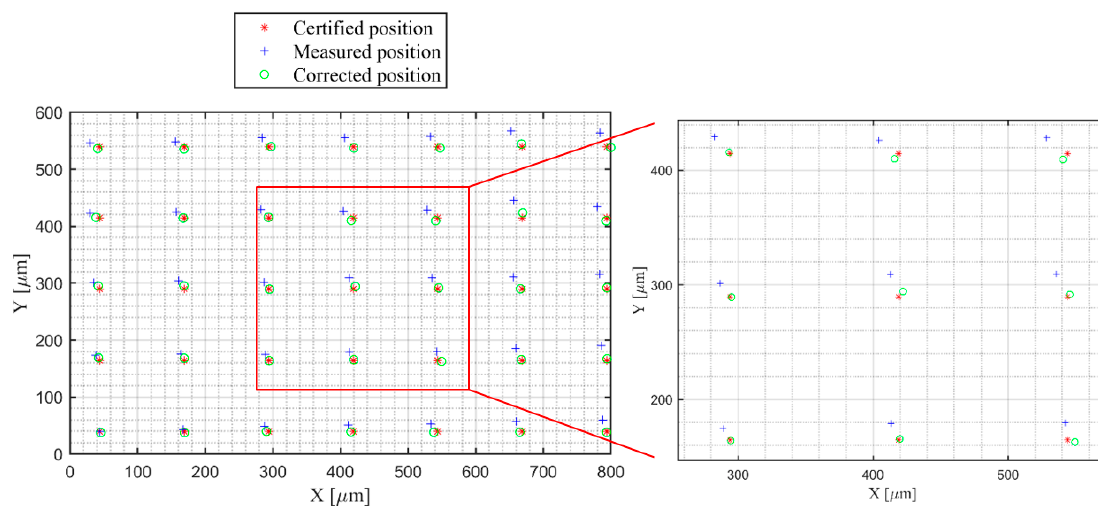
Figure 11. Comparison of the positions of certified, measured, and corrected points. Table 2. Errors with respect to the certified positions before correction and after correction.